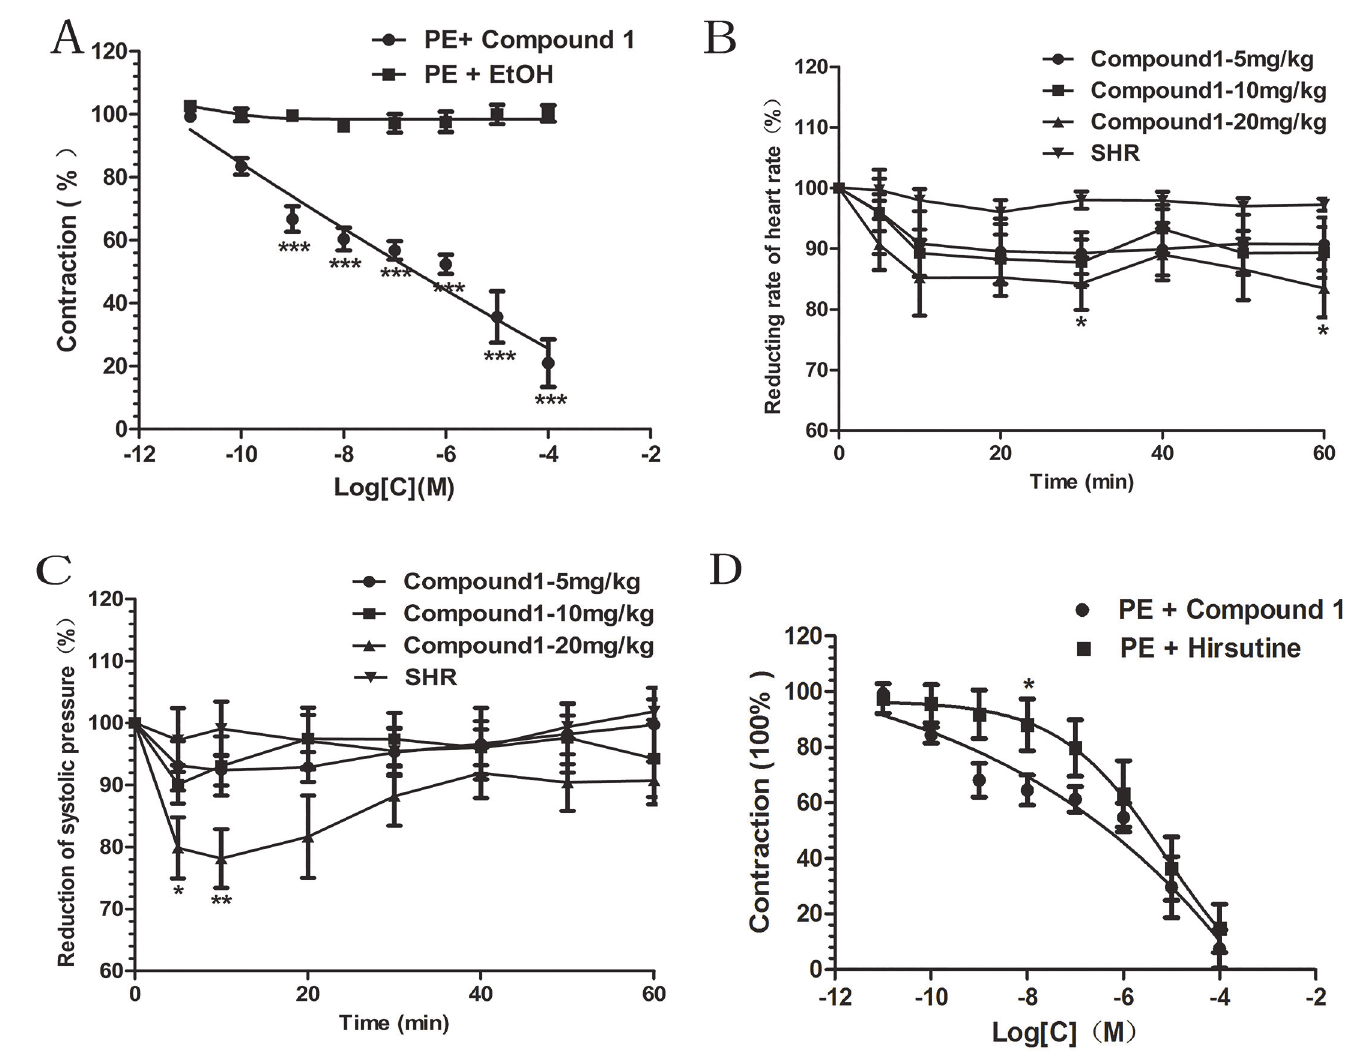
Fig 3. Effect of vasodilation and anti-hypertension. A. Cumulative concentration of compound 1 -induced relaxation precontracted with 1 μ M PE in rat aortic rings with functionally intact endothelium. Means ± S.E.M, n = 6 rings, *** P < 0.001vs Ethanol control group. B. The reduction rate of systolic blood pressure (SBP). C. The reduction rate of heart rate. Results are presented as mean ± S.E.M., n = 6, * P < 0.05, ** p < 0.01vs SHR group. D. The different effect between compound 1 and natural hirsutine relaxation. Results are presented as mean ± S.E.M., n = 6, * P < 0.05 compared with compound 1